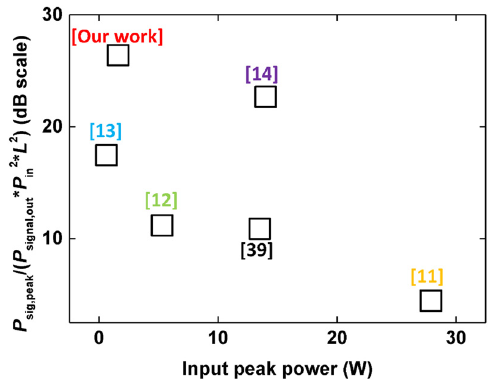
Figure 8: Comparison of on/off parametric gains among on-chip parametric amplifiers of Ref. [11 – 14, 39], and our